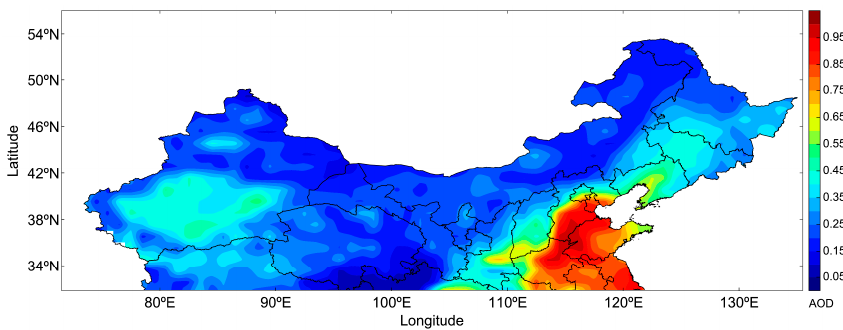
Figure 2. Annual mean AOD at 550 nm over North China for the period 2001–2016. Atmosphere 2017 , 8 , 223